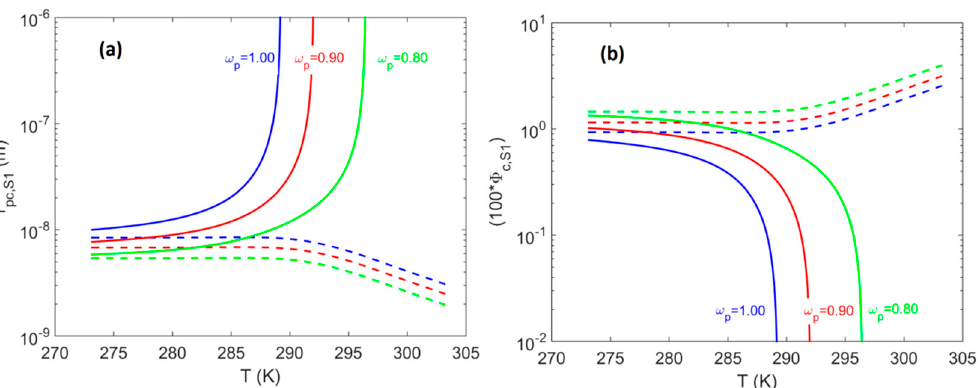
Figure 7. System of a single spherical pore-body (i.e., system S1). ( a ) Effect of the remaining liquid film thickness inside a spherical pore on the critical pore-body radius, r pc , S 1 , plotted as a function of temperature along the three-phase (H–L w –V) equilibrium line for the methane + water system (modified from Tsimpanogiannis [60]). ( b ) Effect of the remaining liquid film thickness inside a spherical pore on the value of ( 100 ∗ Φ c , S 1 ) , plotted as a function of temperature along the same three-phase equilibrium line. When ω p = 1, there was no liquid film on the pore-body wall. Solid lines correspond to pores located at the hydrate-dissociation front ( P l = P bulk eq ) , while the dashed lines correspond to pores at minimum pore pressure ( P l = 0 ) for well production via a pressure depletion scheme.